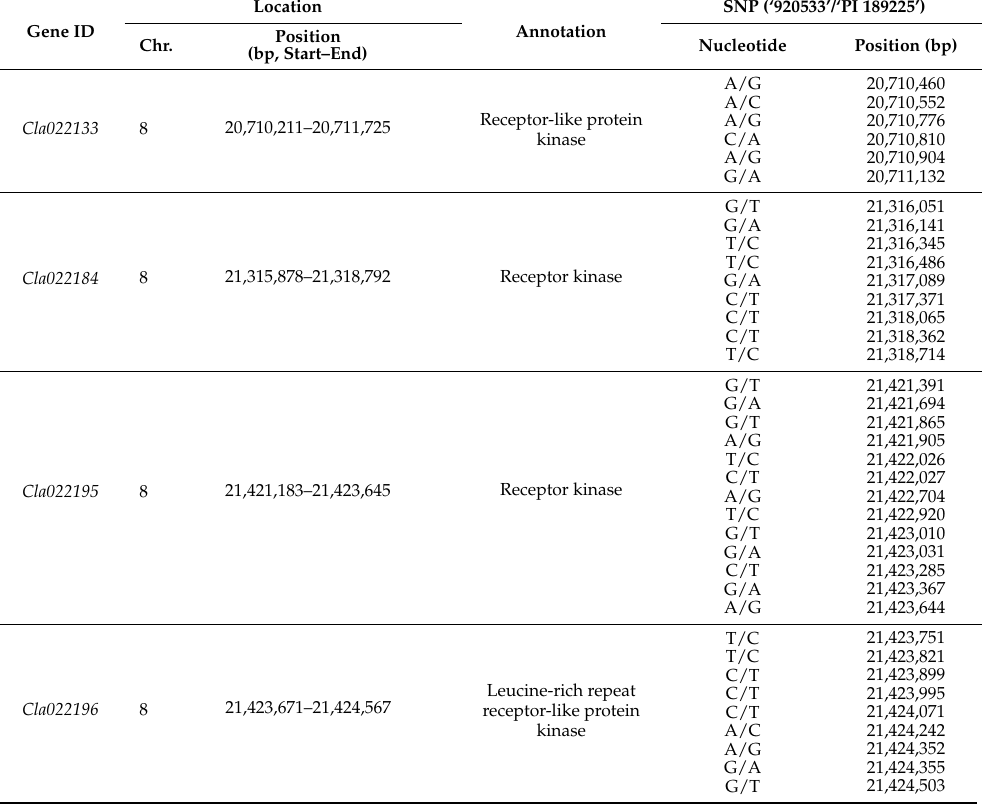
Table 5. Candidate genes associated with gummy stem blight (GSB) resistance and their Gene Ontology (GO)